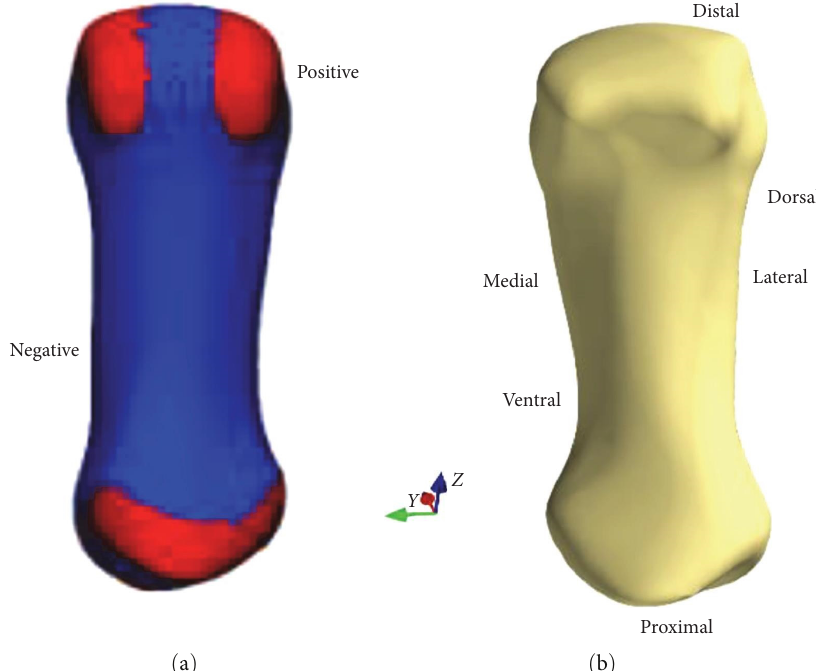
F IGURE 2: Region de fi nition with Gaussian curvature analysis (a). Red area represents positive, blue area represents negative. De fi nition of anatomical terms of location in the view of frontal plane